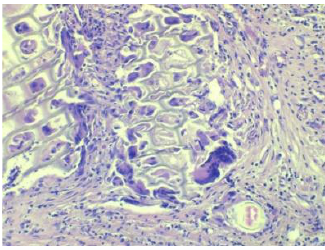
Figure 6. Giant foreign cell reaction at six weeks after surgery.